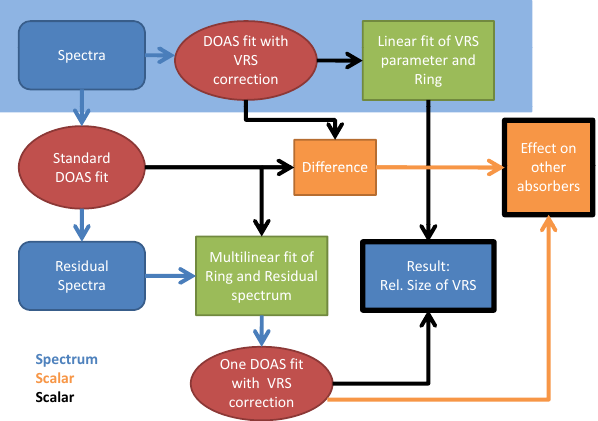
Figure 7. The first line of this diagram shows the procedure which led to Fig. 5: the VRS correction spectrum is added to the fit sce- nario, applied to all spectra and then the obtained fit coefficients are correlated with the Ring signal. The other approach (Sect. 4.2) uses a standard DOAS fit (without VRS correction), correlates the resid- uals with the obtained coefficients from the fit and then uses this result to identify a VRS correction spectrum and its coefficients in one final DOAS fit, which is shown in Fig.